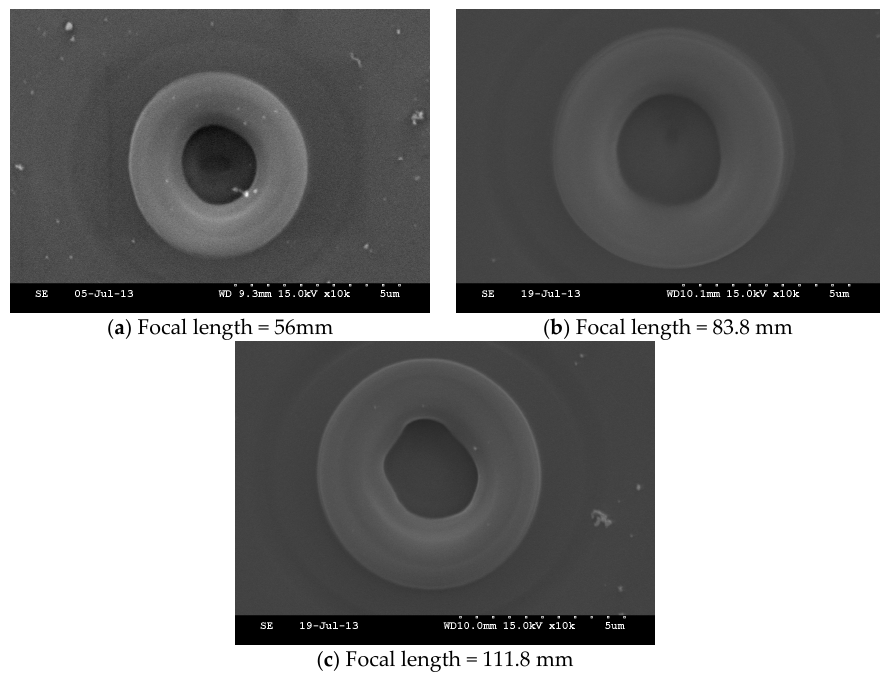
Figure 17. SEM picture of machined holes with a power density of 1.0 × 10 8 W/cm 2 (Scale bar = 5 μ m).